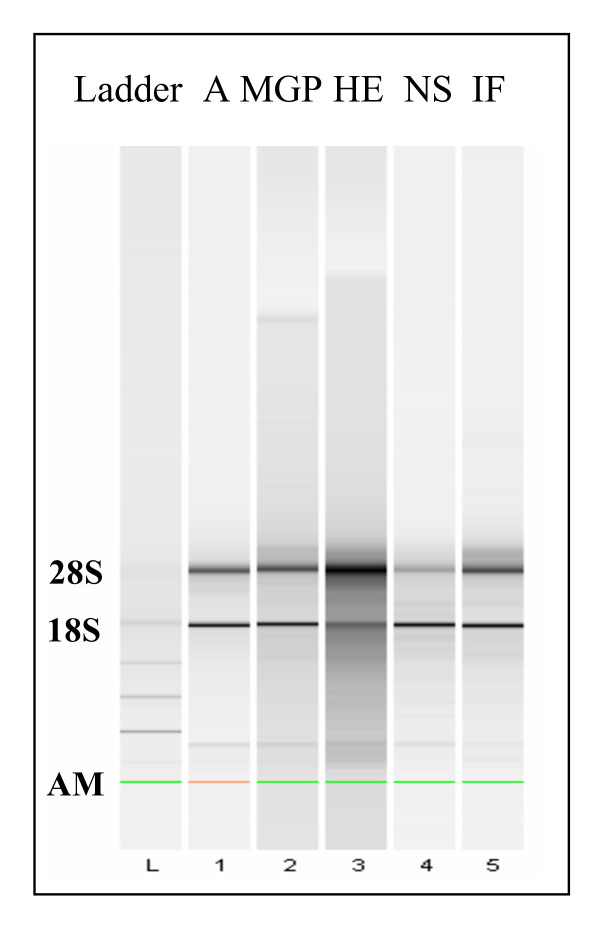
Analysis of RNA quality. One ng of total RNA from one sample from each staining group was electrophoresed on Agilent Bioanalyzer system (Pico RNA chip). RNA ladder 6000 (Ambion, Inc). Lane A contains total RNA from unsectioned cell pellets. Lanes marked MGP, H&E, NS and IF indicate the staining method used before LCM procurement and RNA preparation. Lowermost band (green) in all lanes is an Agilent alignment marker.